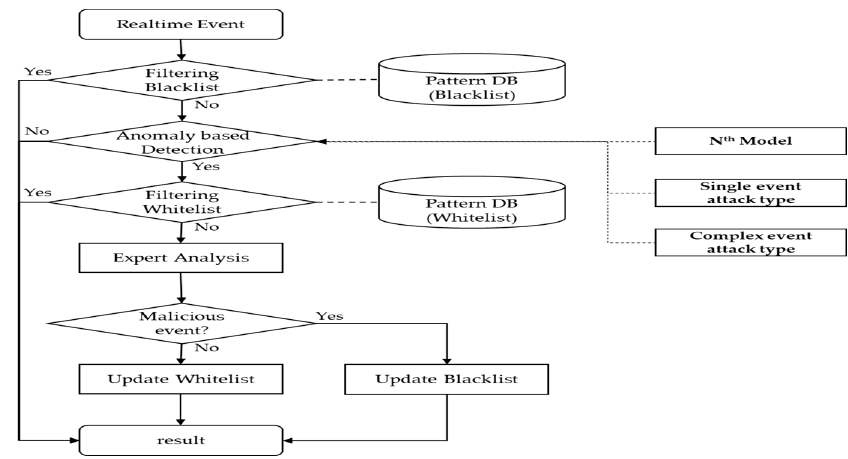
Figure 10. Proposed policy flow chart. Table 10. Example of reduction of review targets through allowlist